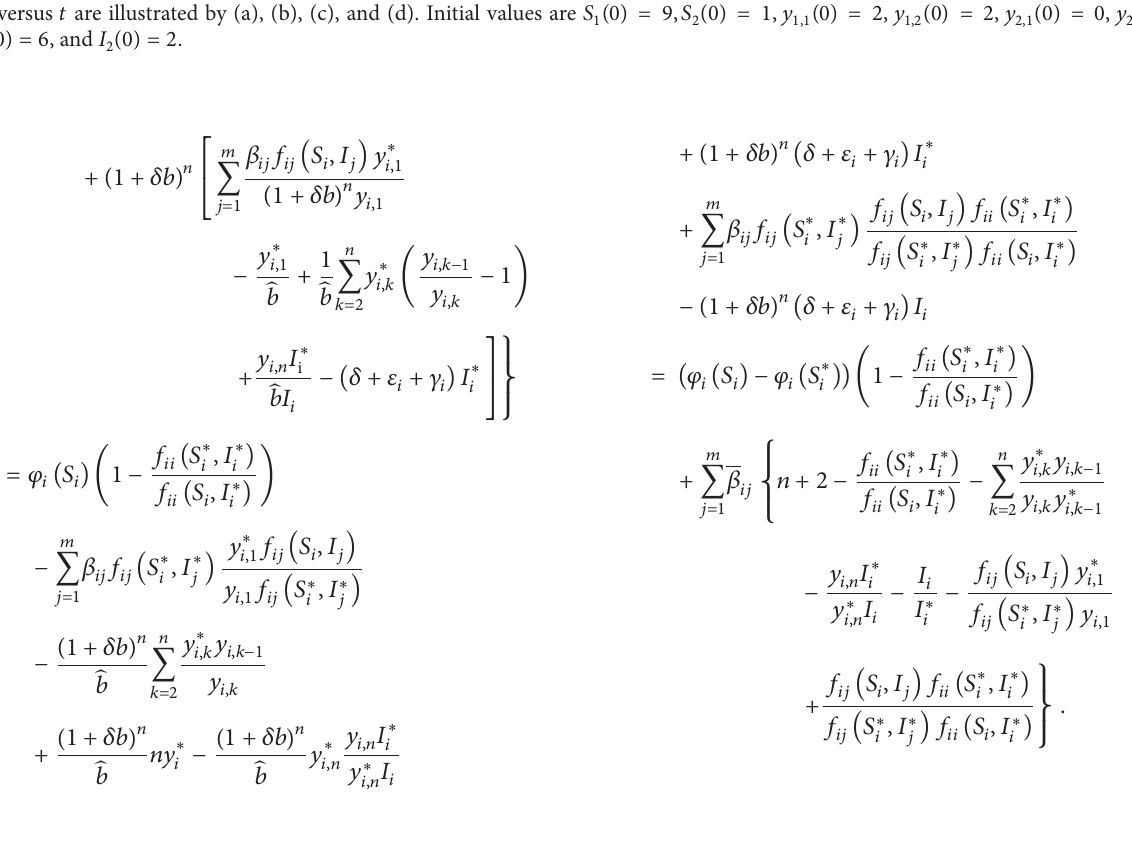
(0) = 9, 𝑆 (0) = 1, 𝑦 (0) = 2, 𝑦 (0) = 2, 𝑦 (0) = 0, 𝑦 (0) = 1 2 1,1 1,2 2,1 2,2